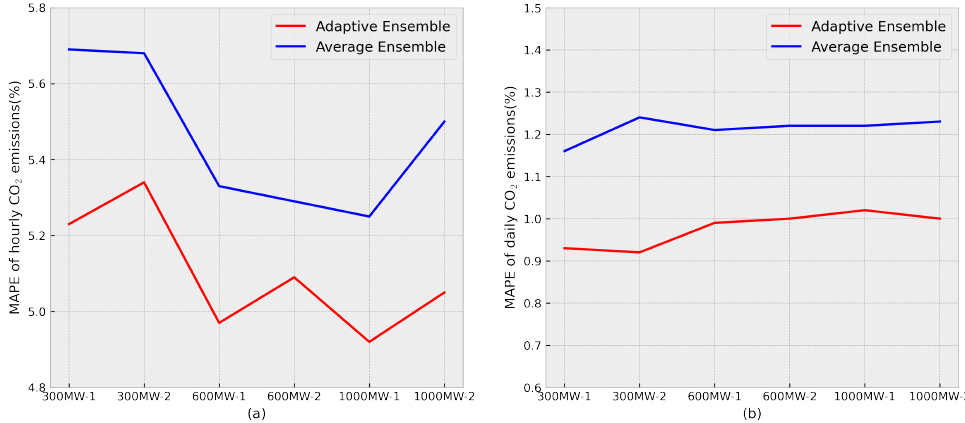
Figure 14. Ablation study of ensembling: Comparing the performance of different ensemble methods on hourly and daily CO 2 emission estimation. ( a ) The MAPE of daily emission estimation; ( b ) the MAPE of hourly emission estimation.